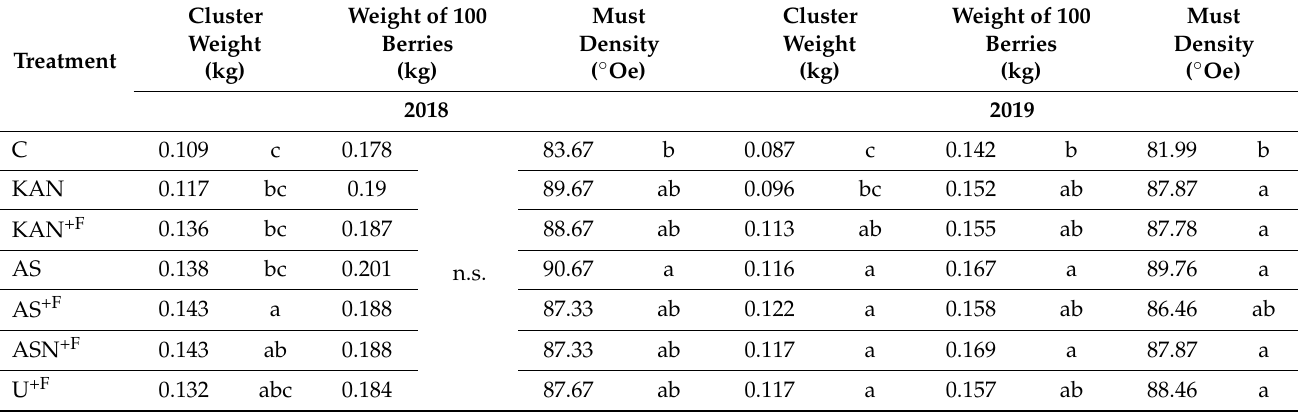
Table 7. Influence of nitrogen fertilization and foliar fertilization on cluster weight, weight of 100 berries and grape must